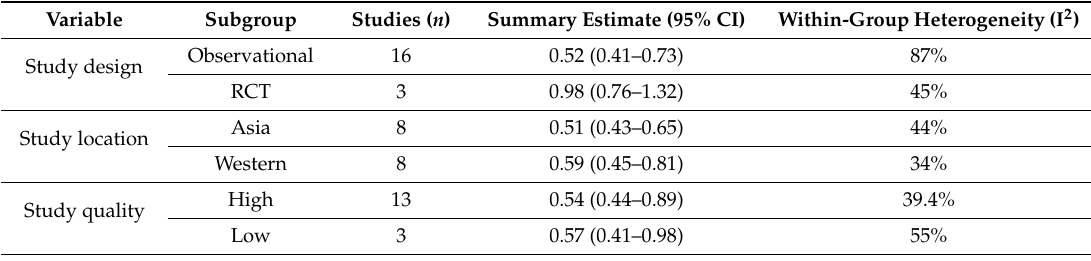
Table 3. Sensitivity analysis of the main diagnostic outcome (odds ratio for hepatocellular carcinoma occurrence) performed based on: (a) study design (observational versus RCT); (b) study location (Asia versus western); and (c) study quality (high versus